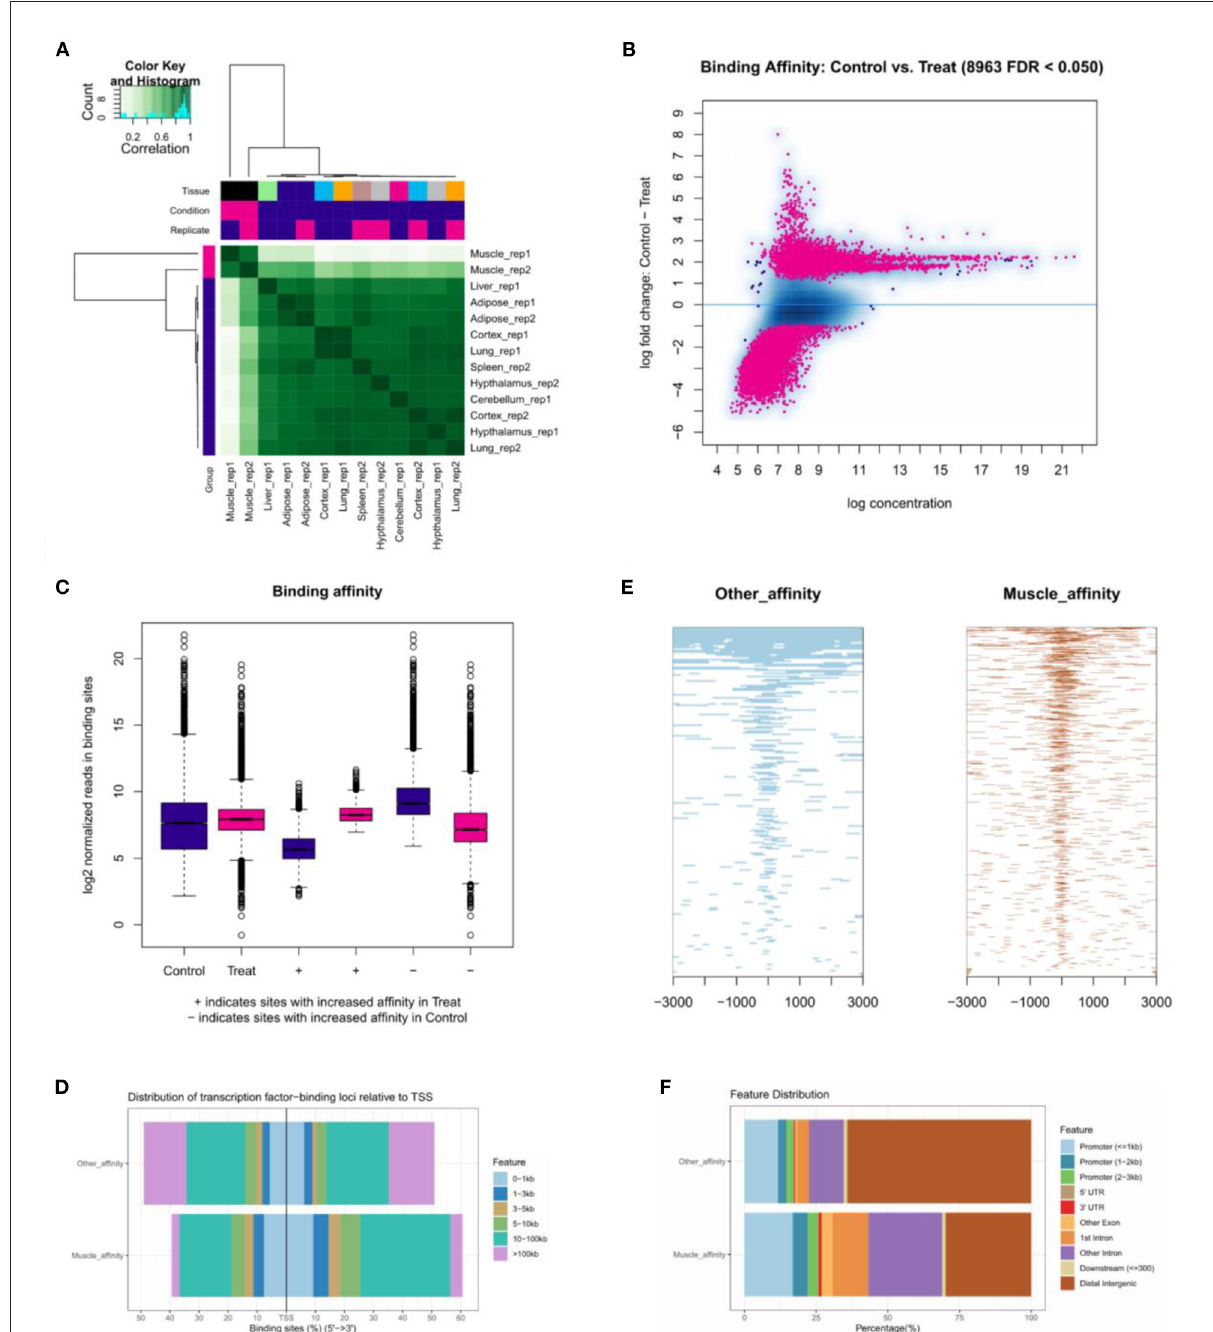
FIGURE5 The landscape of genomic chromatin accessibility. (A) The correlative heatmap of tissues; (B) MA plot of difference peaks analysis; (C) The box-plot of binding affinity; (D) The location distribution of different peaks distance TSS; (E) The heatmap of peaks around TSS; (F) The distribution of function regions of different